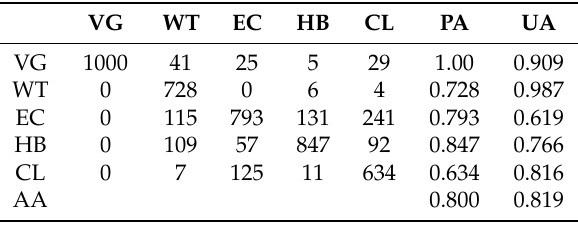
Table 13. Confusion matrix of the CART in the first area.